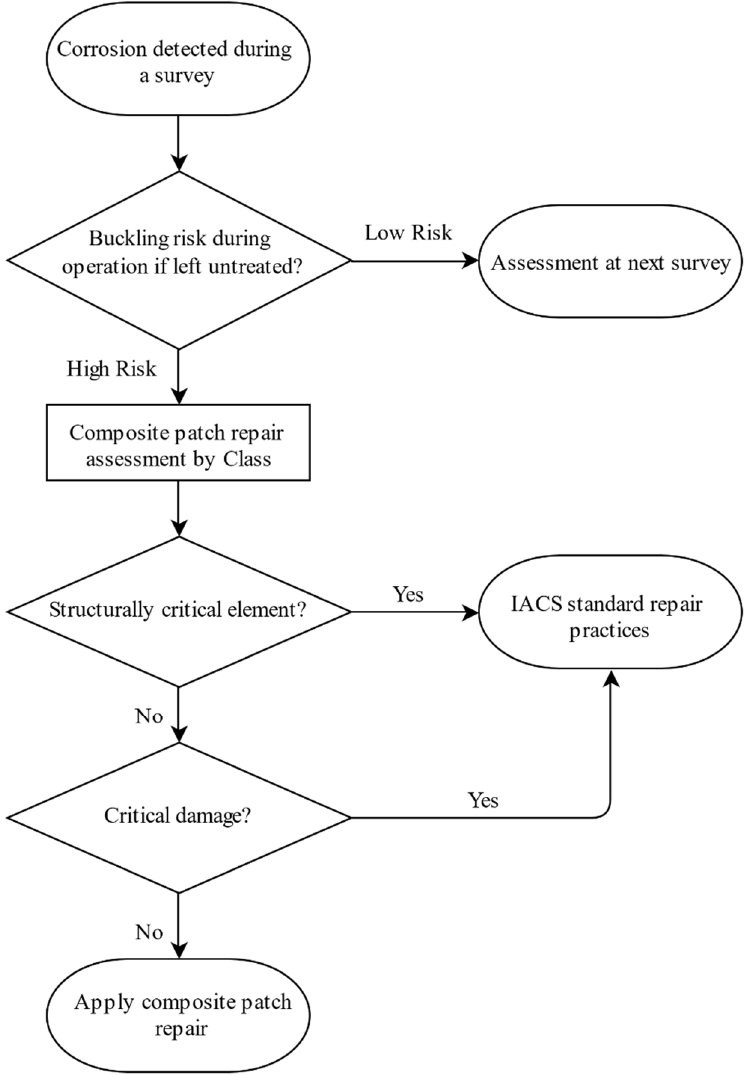
Figure 5. Flowchart illustrating the decision points from the defect detection to the approved repair method.